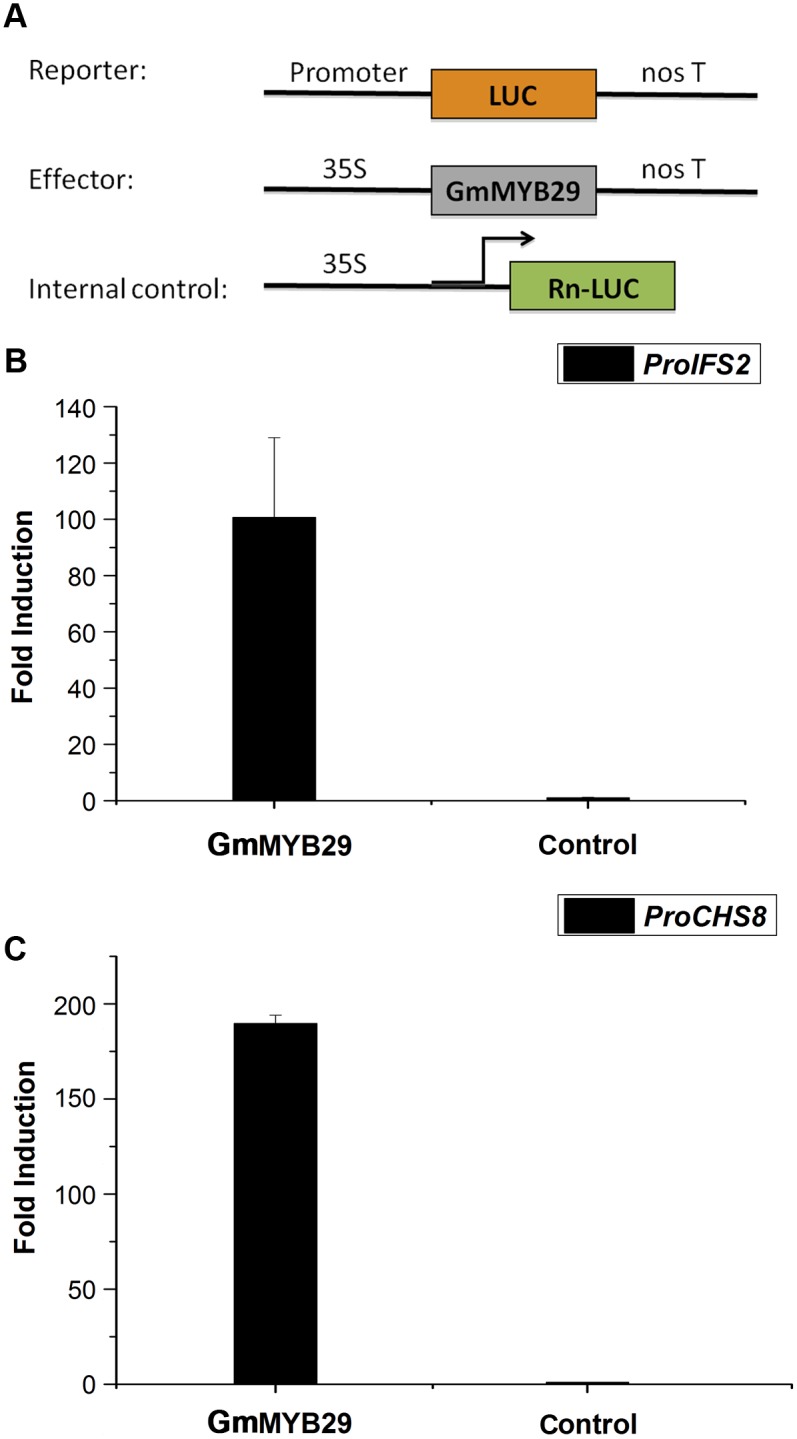
GmMYB29 induced the promoter activity of IFS2 and CHS8, which are key structural isoflavone biosynthesis genes.(A) Schematic representation of the reporter, effector and internal control constructs used in the transient assays. (B) GmMYB29 induced the promoter activity of IFS2. GmMYB29 column represents relative LUC activity (Firefly/Renilla) of the IFS2 promoter plus GmMYB29 factor relative to the control (without the GmMYB29 factor). The control contains the reporter and internal control plasmids. Bars indicate the standard errors of three technical replicates for three independent biological replicates. (C) GmMYB29 induced the promoter activity of CHS8. GmMYB29 column represents relative LUC activity (Firefly/Renilla) of the CHS8 promoter plus GmMYB29 factor relative to the control (without the GmMYB29 factor). The control contains the reporter and internal control plasmids. Bars indicate the standard errors of three technical replicates for three independent biological replicates.